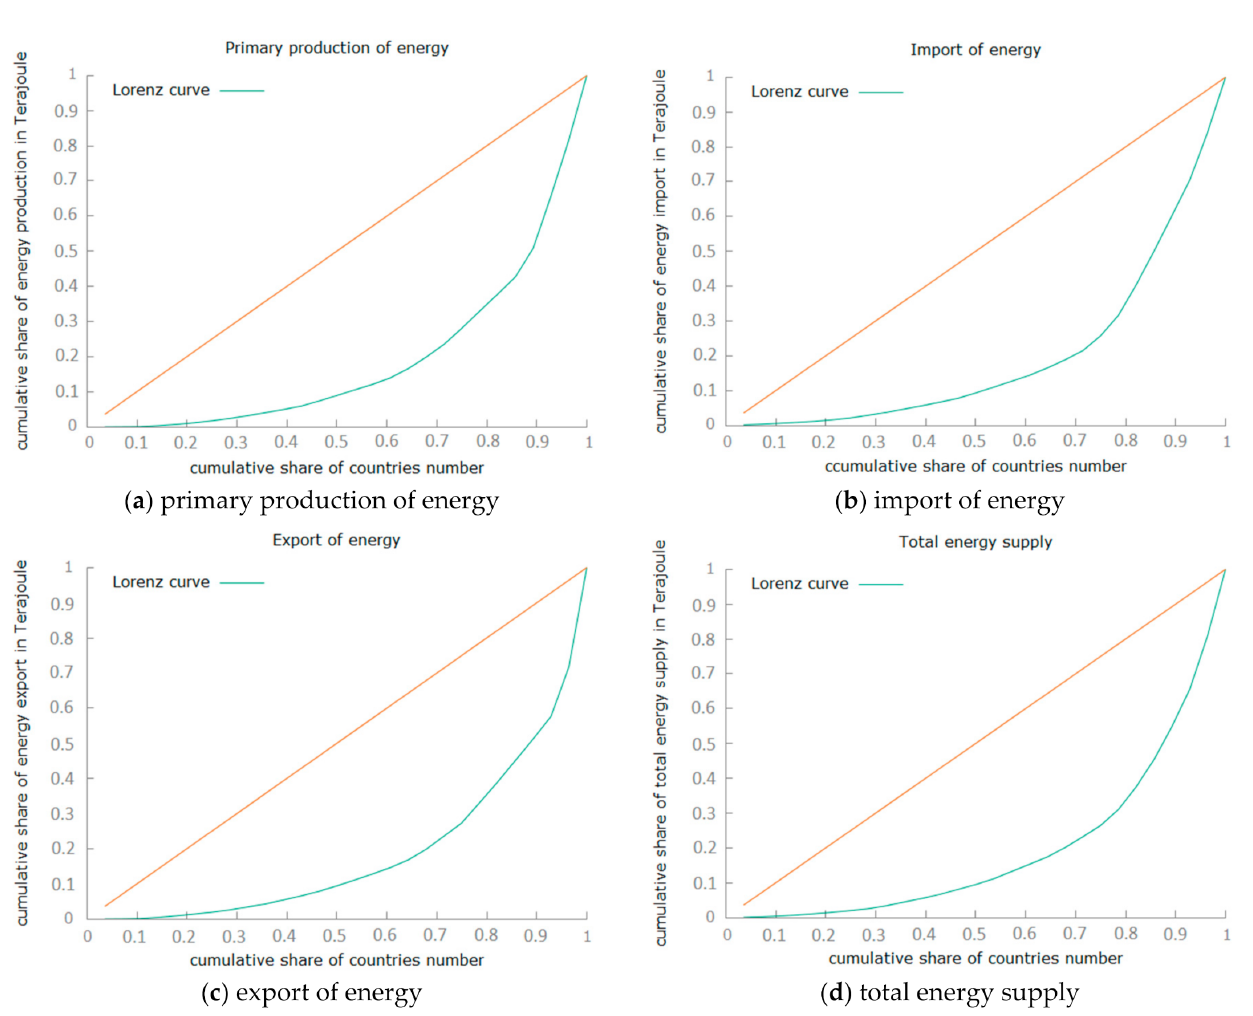
Figure 2. Lorenz concentration curves for energy balance parameters in the EU countries in 2018. Source: Own study based on